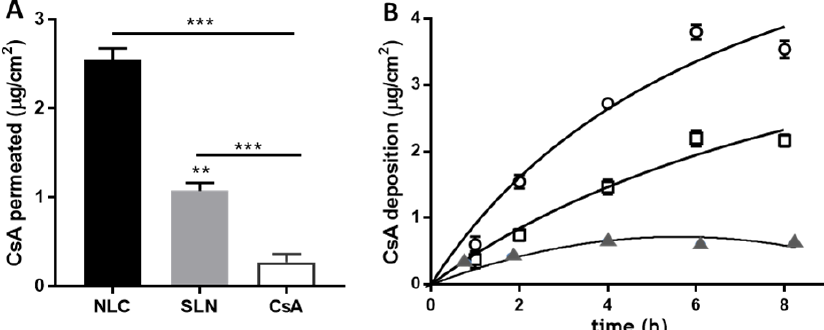
Figure 5. CsA skin delivery from SLNs and NLCs formulations. ( A ) Drug permeation and ( B ) CsA deposition from SLNs (squares) and NLCs (circles) as a function of time. A 0.5 mg mL − 1 CsA solution in olive oil (triangles) served as control (data are expressed as mean ± SD; n = 5).